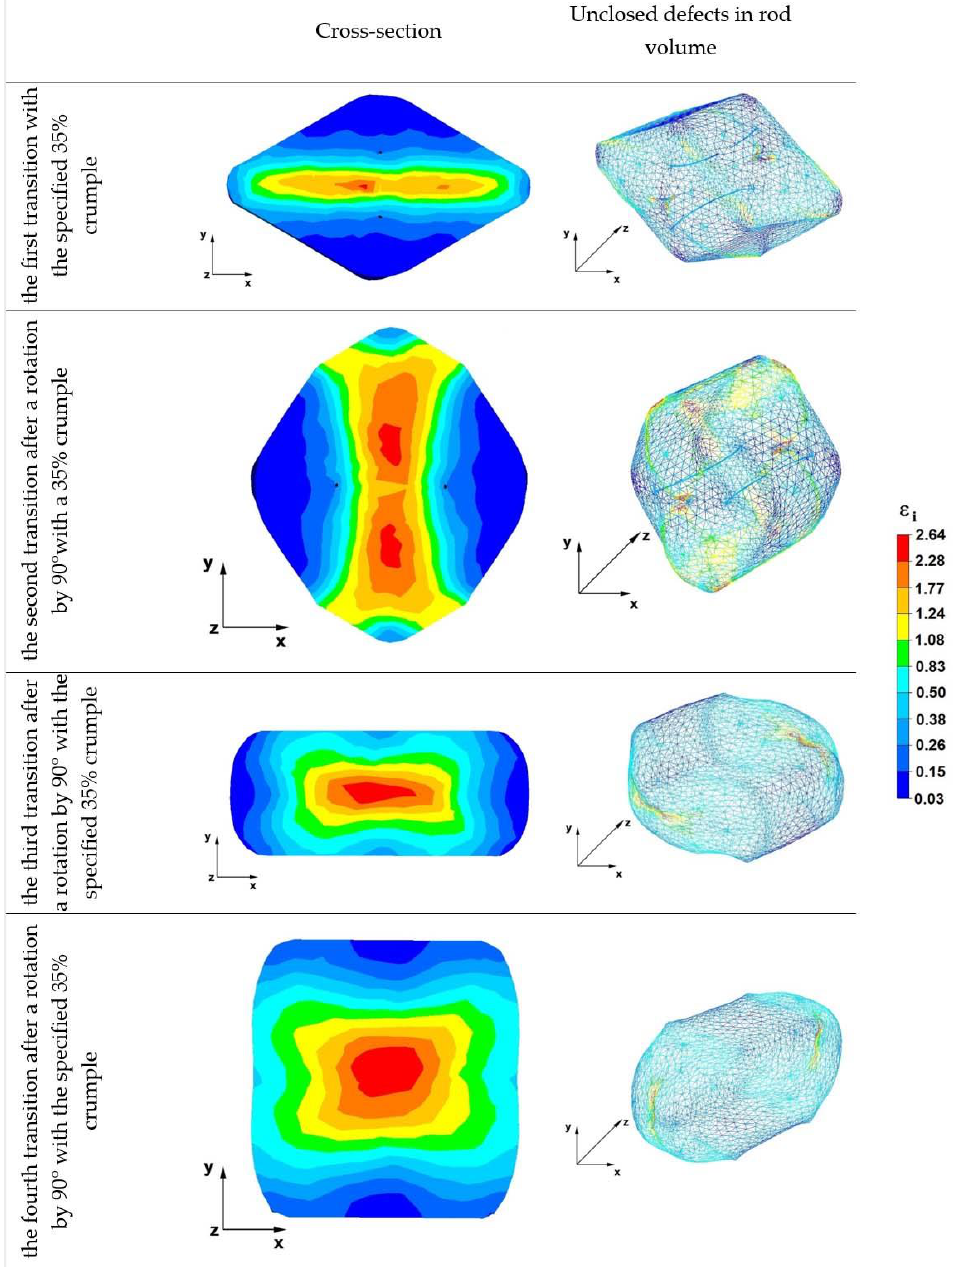
Figure 14. Effective strain distribution rod in rhombic anvils.